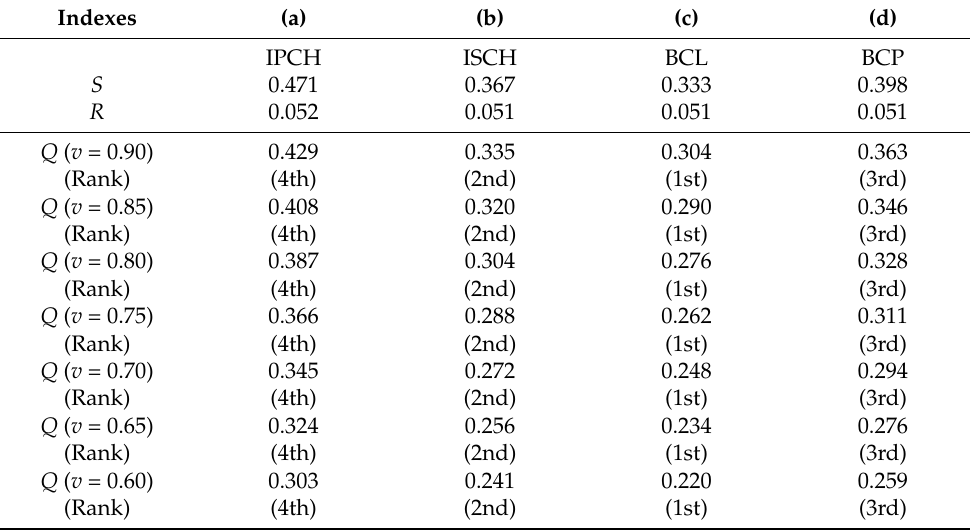
Table A1. Sensitivity analysis of the hybrid approach based on DANP + VIKOR + Confidence-based fuzzy